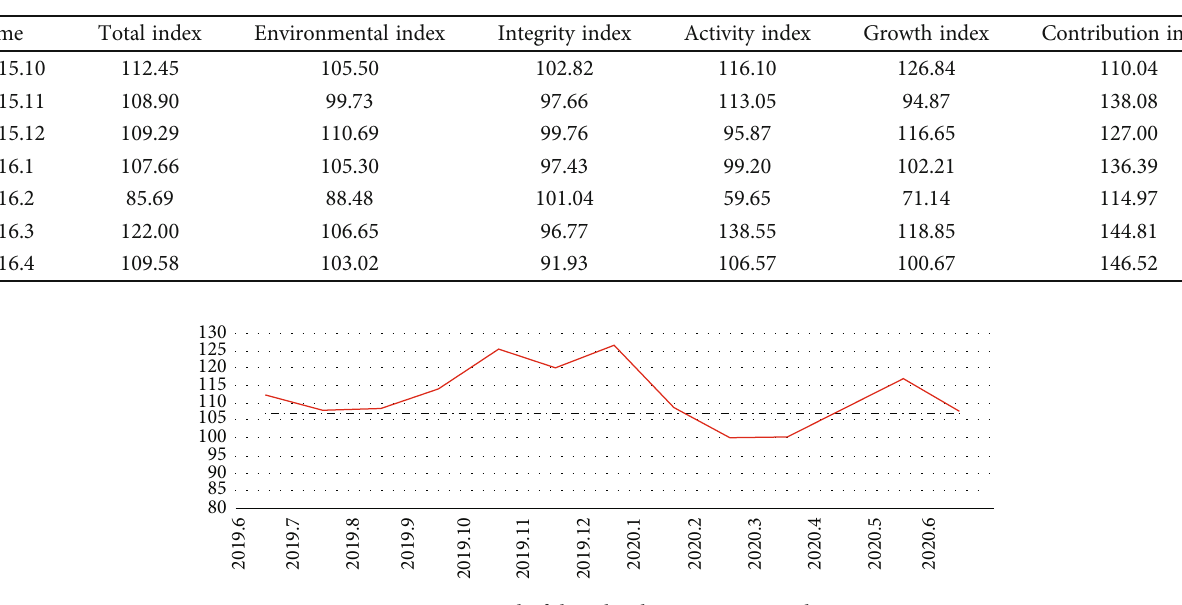
Table 4: Changes of digital industry progress index.